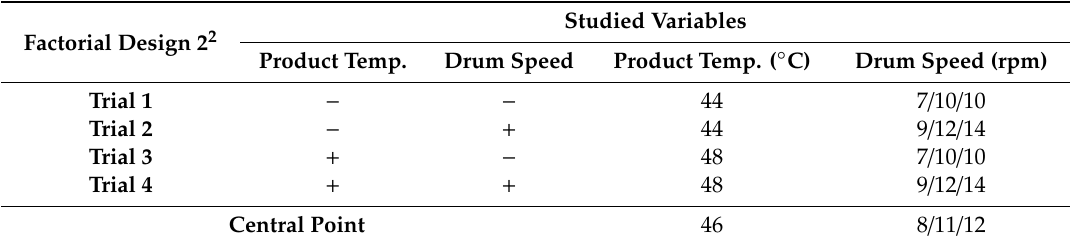
Table 2. Prospective factorial design with the cytostatic drug (two factors to